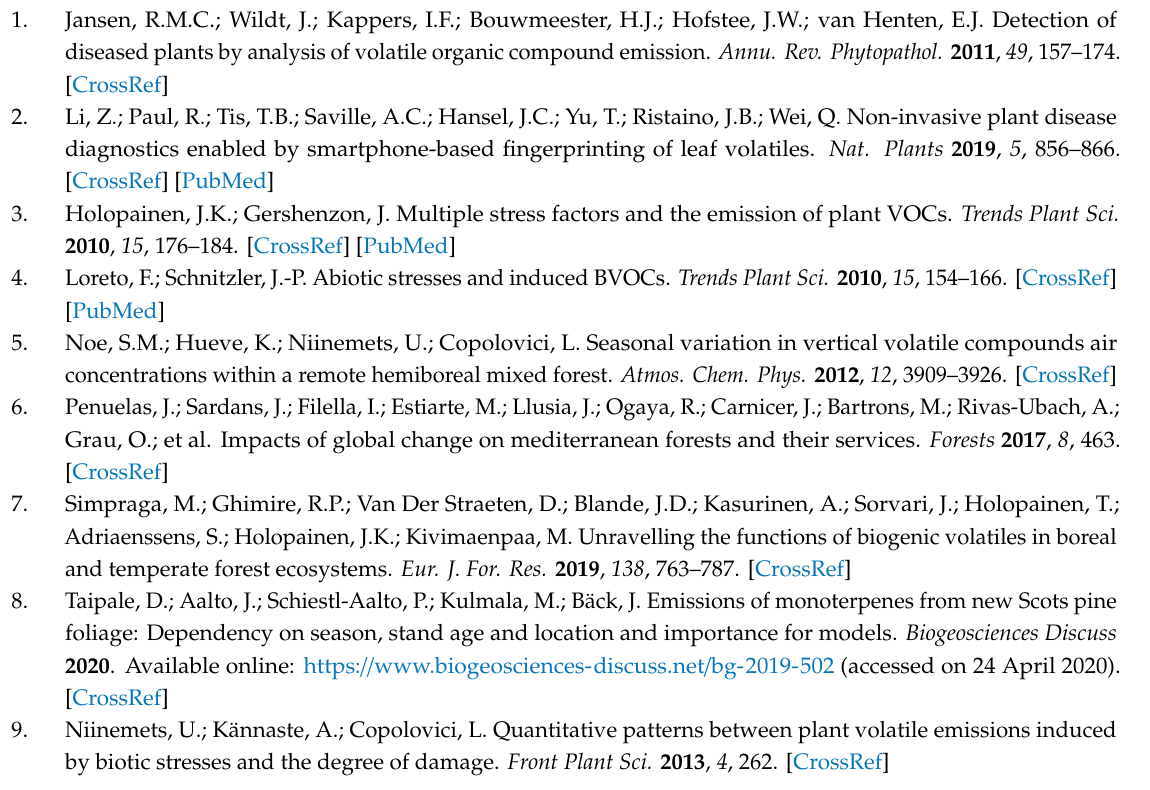
Table S1: Emission rates per needle area (ng cm − 2 h − 1 ) of BVOCs from control and aphid-infested Scots pine saplings before aphid infestation and at di ff erent days after aphid infestation in Experiment 1. Table S2: Average (SE) ( n = 6) of systemic BVOC emission rates (ng cm − 2 h − 1 ) collected from an uninfested branch adjacent to an aphid-infested Scots pine branches and from control trees 39 days after aphid-infestation (Experiment